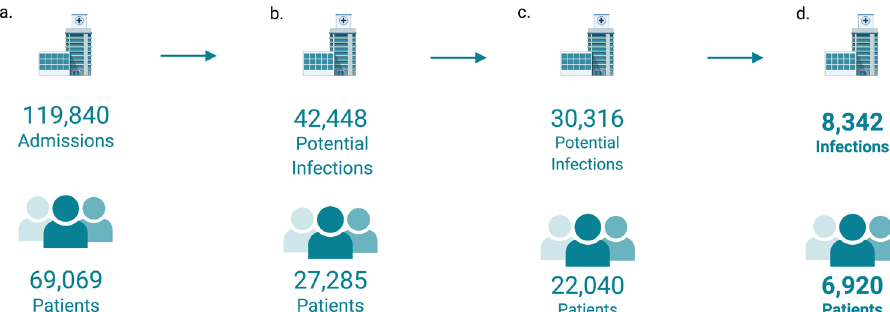
Fig. 1 Study cohort selection. a 119,840 hospital admissions corresponding to 69,069 unique adult patients admitted from Stanford emergency rooms between 2009 and 2019 were initially examined for inclusion. b 42,448 admissions had a microbial culture and intravenous or intramuscular empiric antibiotic order placed within the fi rst 24 h of the encounter. c Admissions were excluded if microbial cultures had been ordered in the 2 weeks leading up to the encounter. d Admissions resulting in negative microbial cultures were excluded in the primary analysis, leaving 8342 infections from 6920 unique